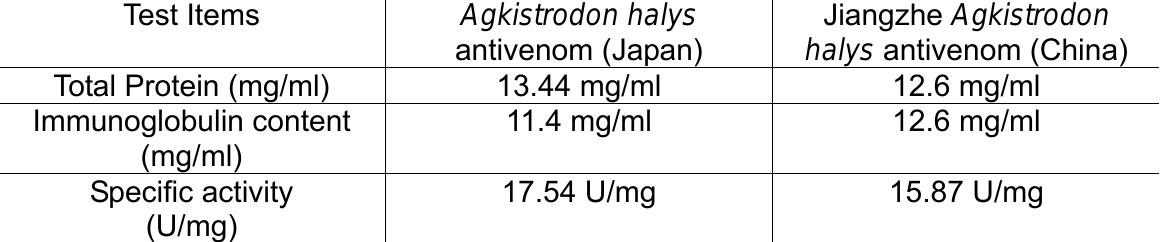
Table 8: Comparison of Agkistrodon halys and Jiangzhe antivenoms specific activities.